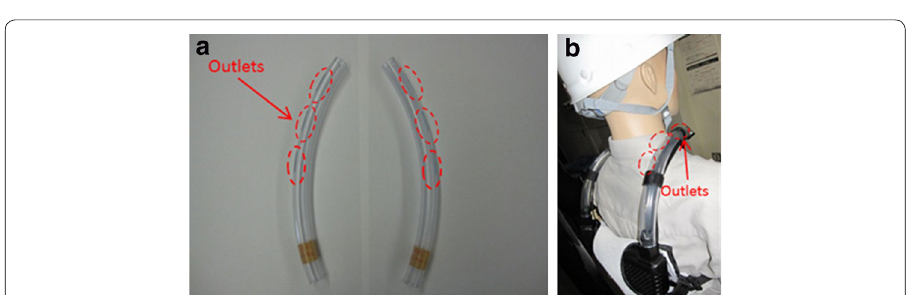
Fig. 2 Details of FANS. a Location of outlets, b placement of FANS to manikin